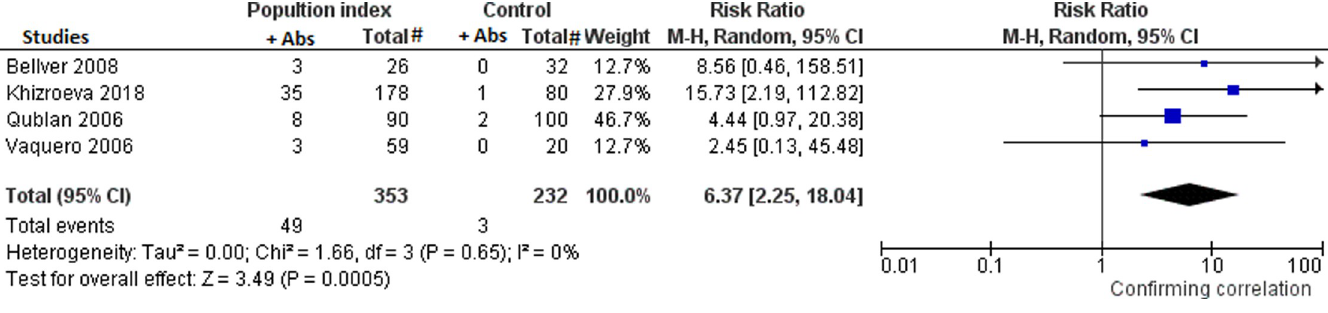
Fig 6. Meta-analysis assessing the risk for implantation failure in relation to the presence or not of anti-PL antibodies in the studies in subgroup B between women with at least two implantation failures in IVF-ET ( population index ) vs women with at least one successful spontaneous pregnancy or unselected healthy fertile women with no history of IVF-ET ( control ). Fig 6: meta-analysis assessing the risk for implantation failure in relation to the presence or not of LA antibodies.